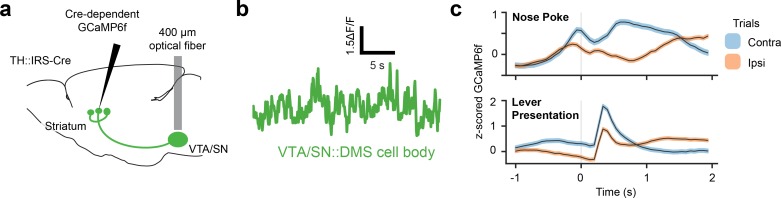
Recording from VTA/SN::DMS cell bodies (n = 7 recording sites).(a) Surgical schematic for recording with optical fibers from the GCaMP6f VTA/SN::DMS cell-bodies. (b) Sample GCaMP6f traces from VTA/SN::DMS cell bodies. (c) Contralateral choice selectivity was also observed in DMS DA cell bodies when the signals were time-locked to nose poke (top) and lever presentation (bottom). Colored fringes represent ±1 standard error from activity averaged across recording sites (n = 7).